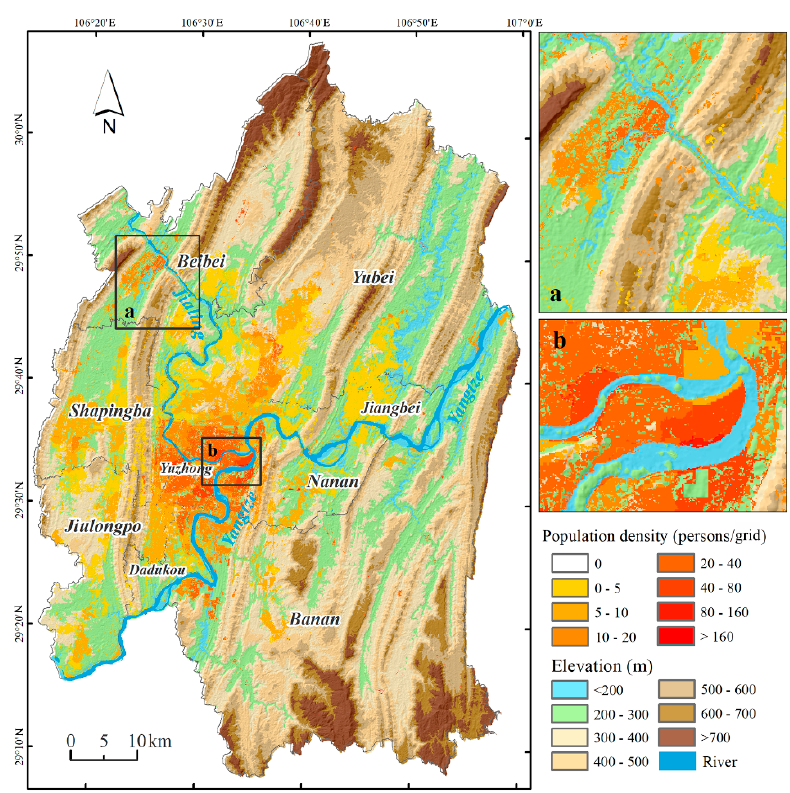
Figure 6. Predicted population per grid cell in central Chongqing in 2018. ( a ) The photomicrograph of Zhongliang Mountain. ( b ) The photomicrograph of Yuzhong Peninsula.